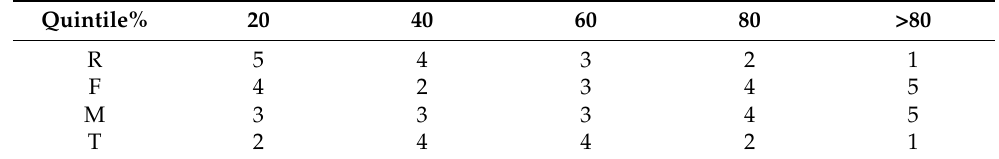
Table 3. Quintile scoring values for each of the RFMT variables.